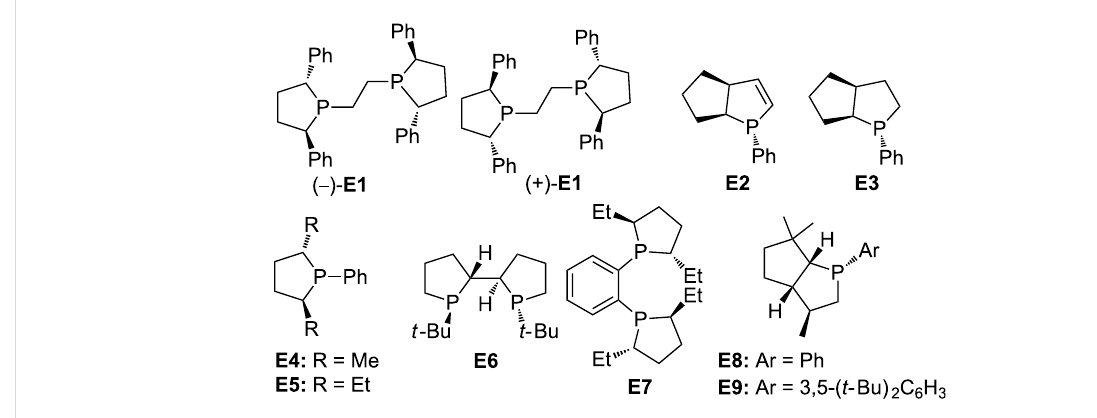
Figure 5: Cyclic chiral phosphines based on phospholane ring skeletons.